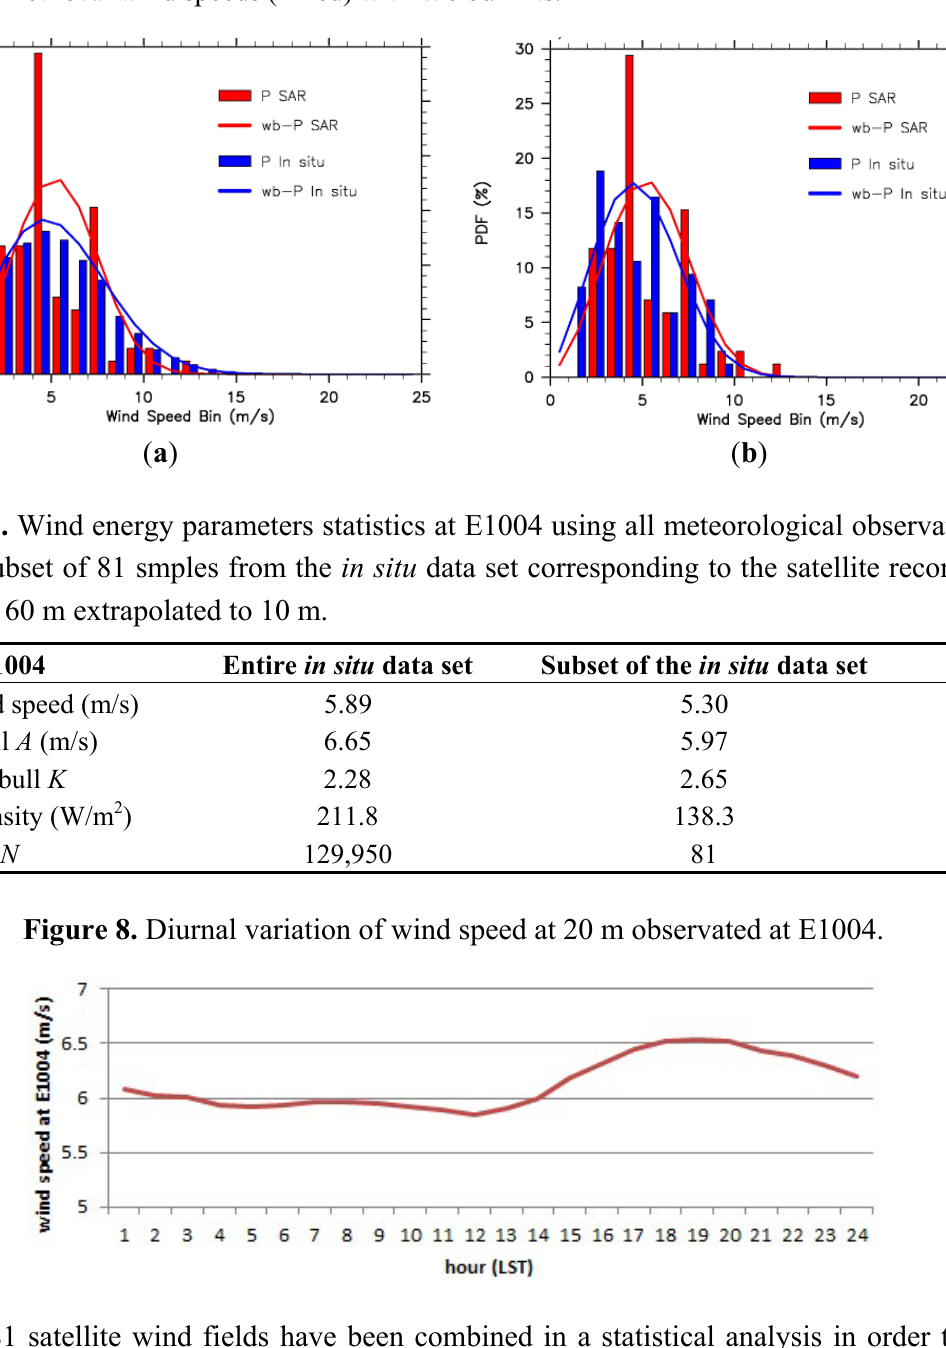
Figure 7. Histogram of wind speed at E1004 of the total 129,950 samples (blue in ( a )) and the 81 samples corresponding to the satellite recording times (blue in ( b )) with Weibull fits, and SAR retrieval wind speeds (in red) with Weibull fits.